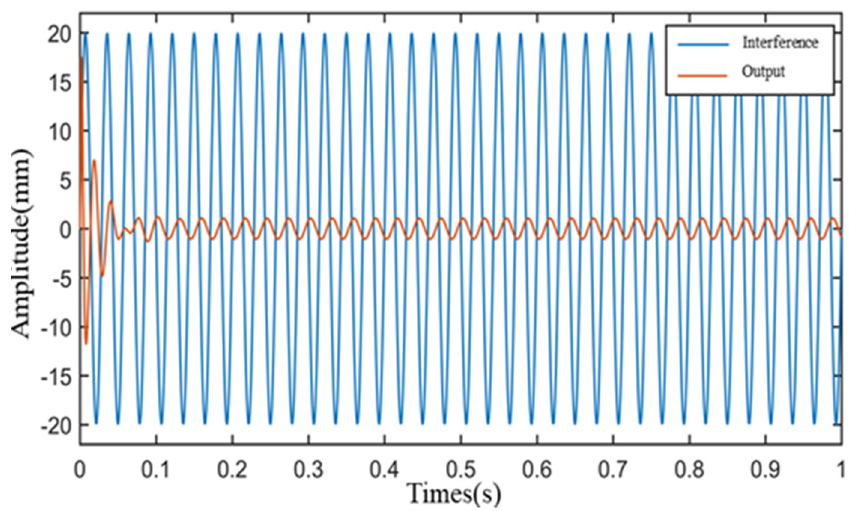
Figure 15. Simulation results of 35 Hz interference.